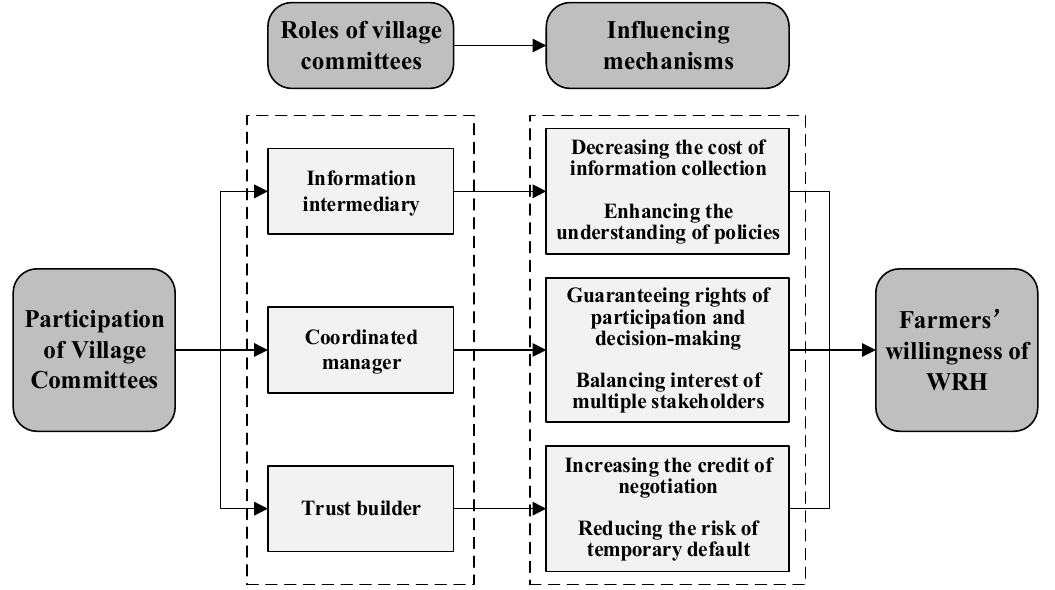
Figure 1. Influencing mechanisms of village committees on the withdrawal from rural homesteads (WRH) in China.